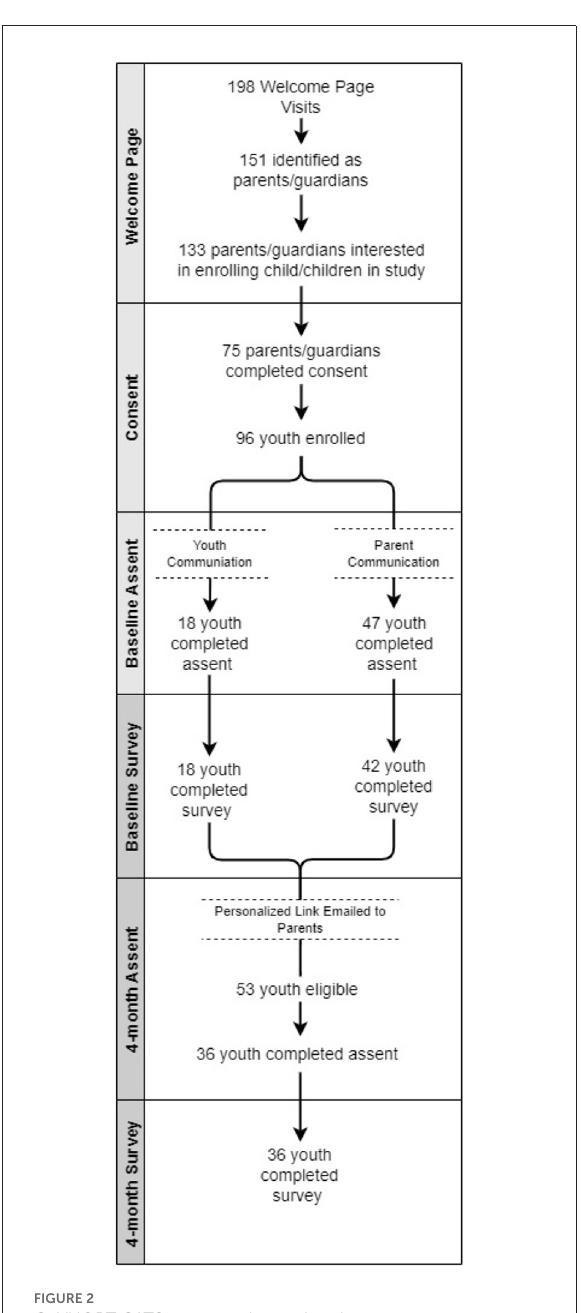
FIGURE2 CoVHORT CATS assent and completed